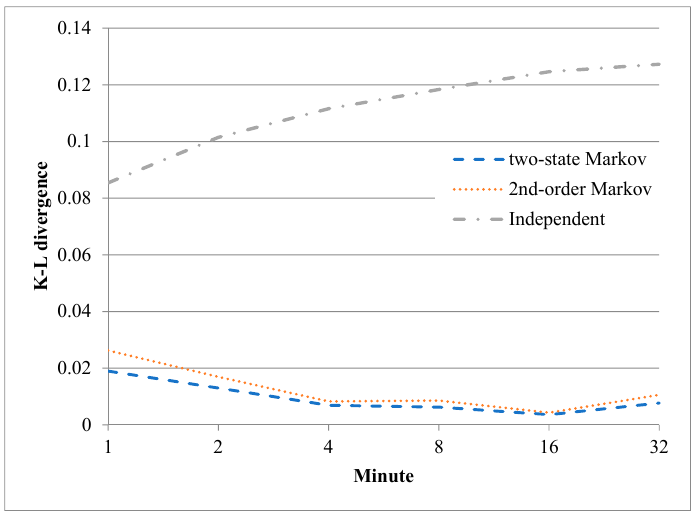
Figure 16. K-L divergence between error-frame bursts of original records and those of synthetic data. Sensors 2020 , 20 , x FOR PEER REVIEW